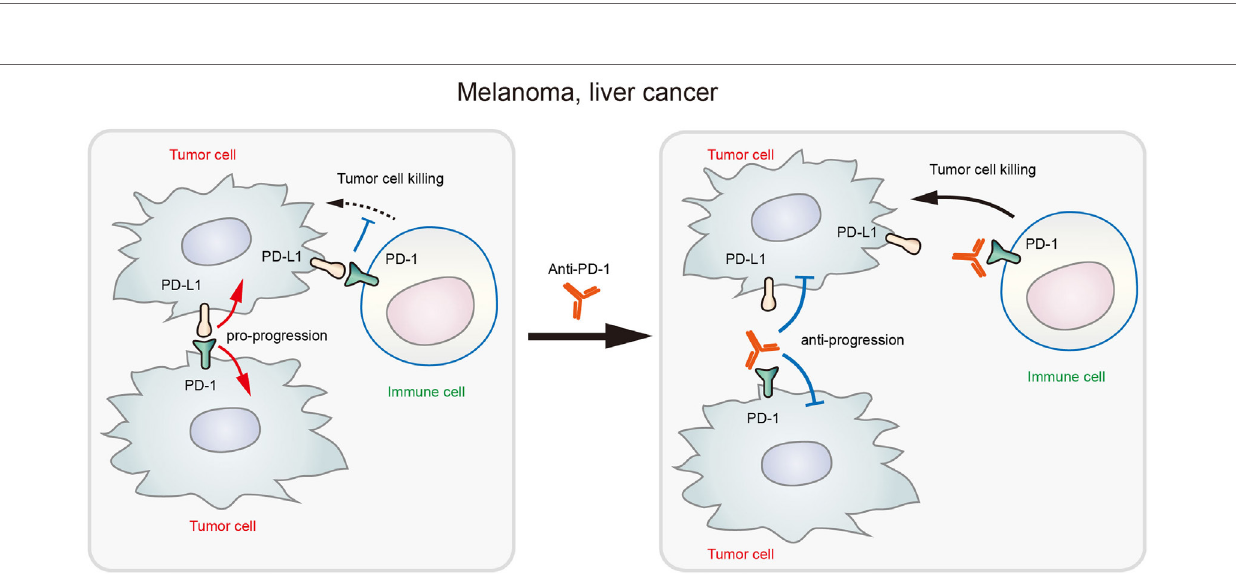
FiGURe 1 | Distinct signaling pathways involved in programmed death 1 (PD-1)/PD-L1 interaction in the tumor microenvironment. Tumor cells may express both PD-L1 and PD-1, but the downstream signaling of PD-1/PD-L1 interaction that occurs in tumor–tumor or tumor–immune cell interfaces may vary considerably. Both the cell type and tumor type may determine the associated signaling pathways.